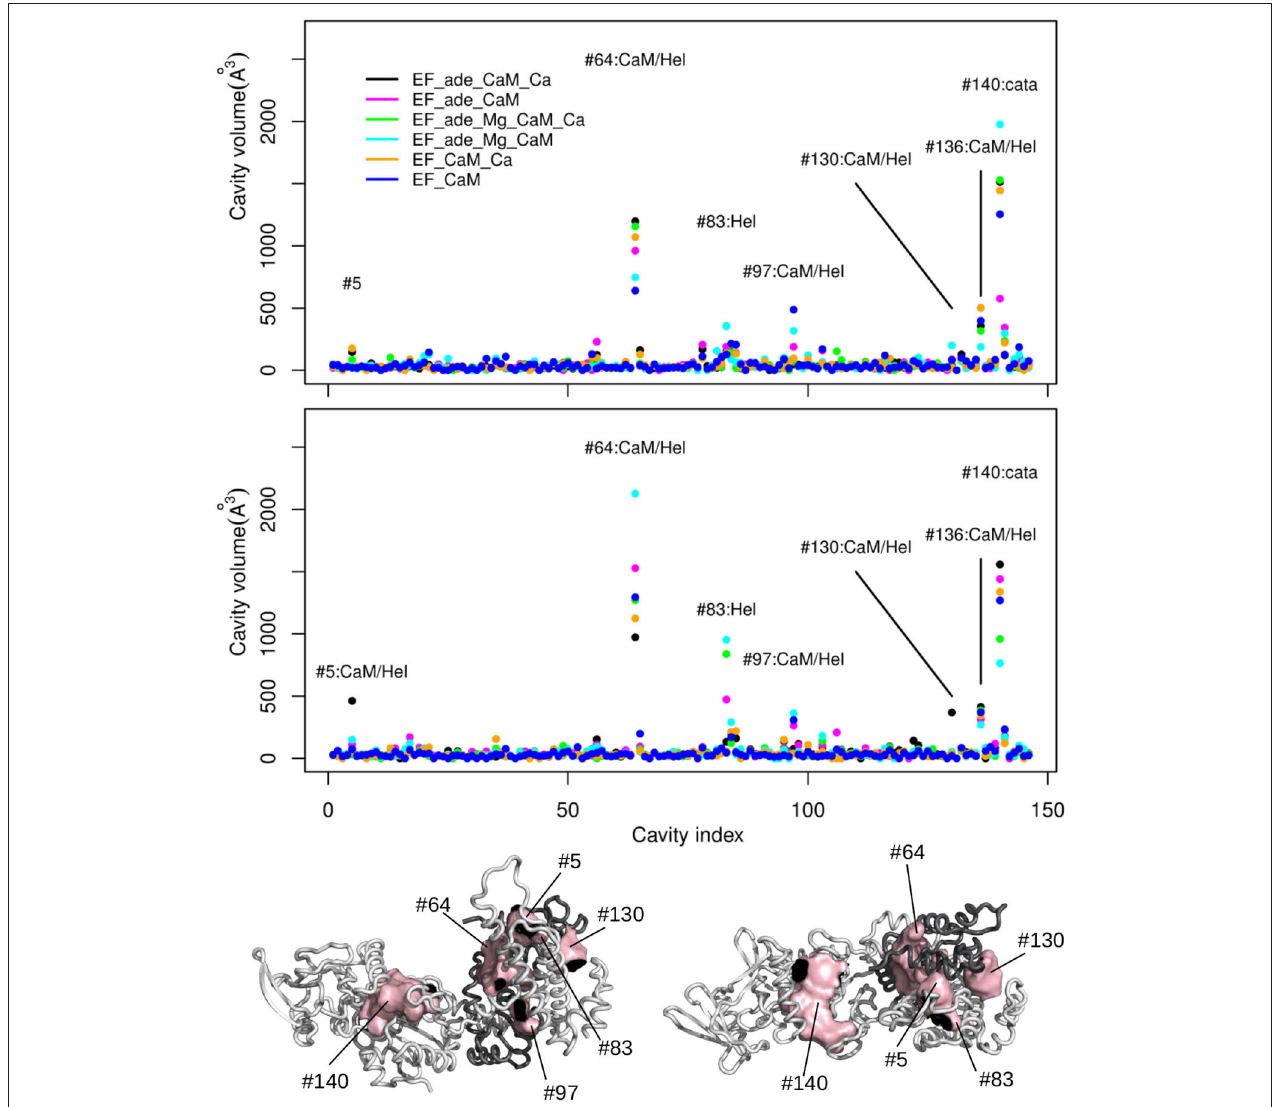
FIGURE 8 | (Top) Averaged volumes (Å 3 ) of the cavities detected by mkgridXf plotted along the cavity index. The two plots correspond to the two replicas series of the trajectories. The points are colored according to the trajectory on which the volume was averaged: EF_ade_CaM_Ca (black), EF_ade_CaM (magenta), EF_ade_Mg_CaM_Ca (green), EF_ade_Mg_CaM (cyan), EF_CaM_Ca (orange), and EF_CaM (blue). The cavities for which at least one volume larger than 250 Å 3 has been observed, are labeled with the cavity number and annotated according to the cavity location: Hel, helical domain; cata, catalytic site; Hel/CaM, interaction interface between helical domain and CaM. (Bottom) Opposite views of the complex EF/CaM with CaM colored in dark gray. The cavities labeled on the plots are drawn in surfaces and colored in pink. CaM is colored in dark